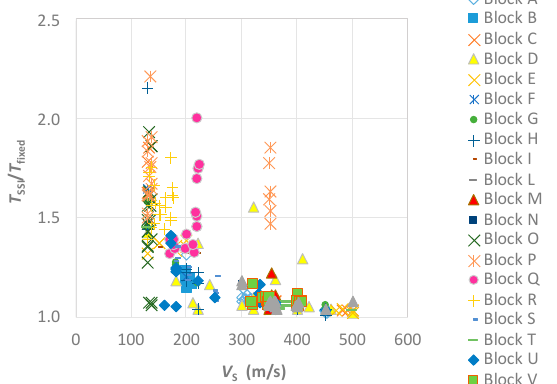
/ T SSI fixed ratios versus the shear waves velocities V s for the south Old Town area. Geosciences 2020 , 10 , x FOR PEER REVIEW